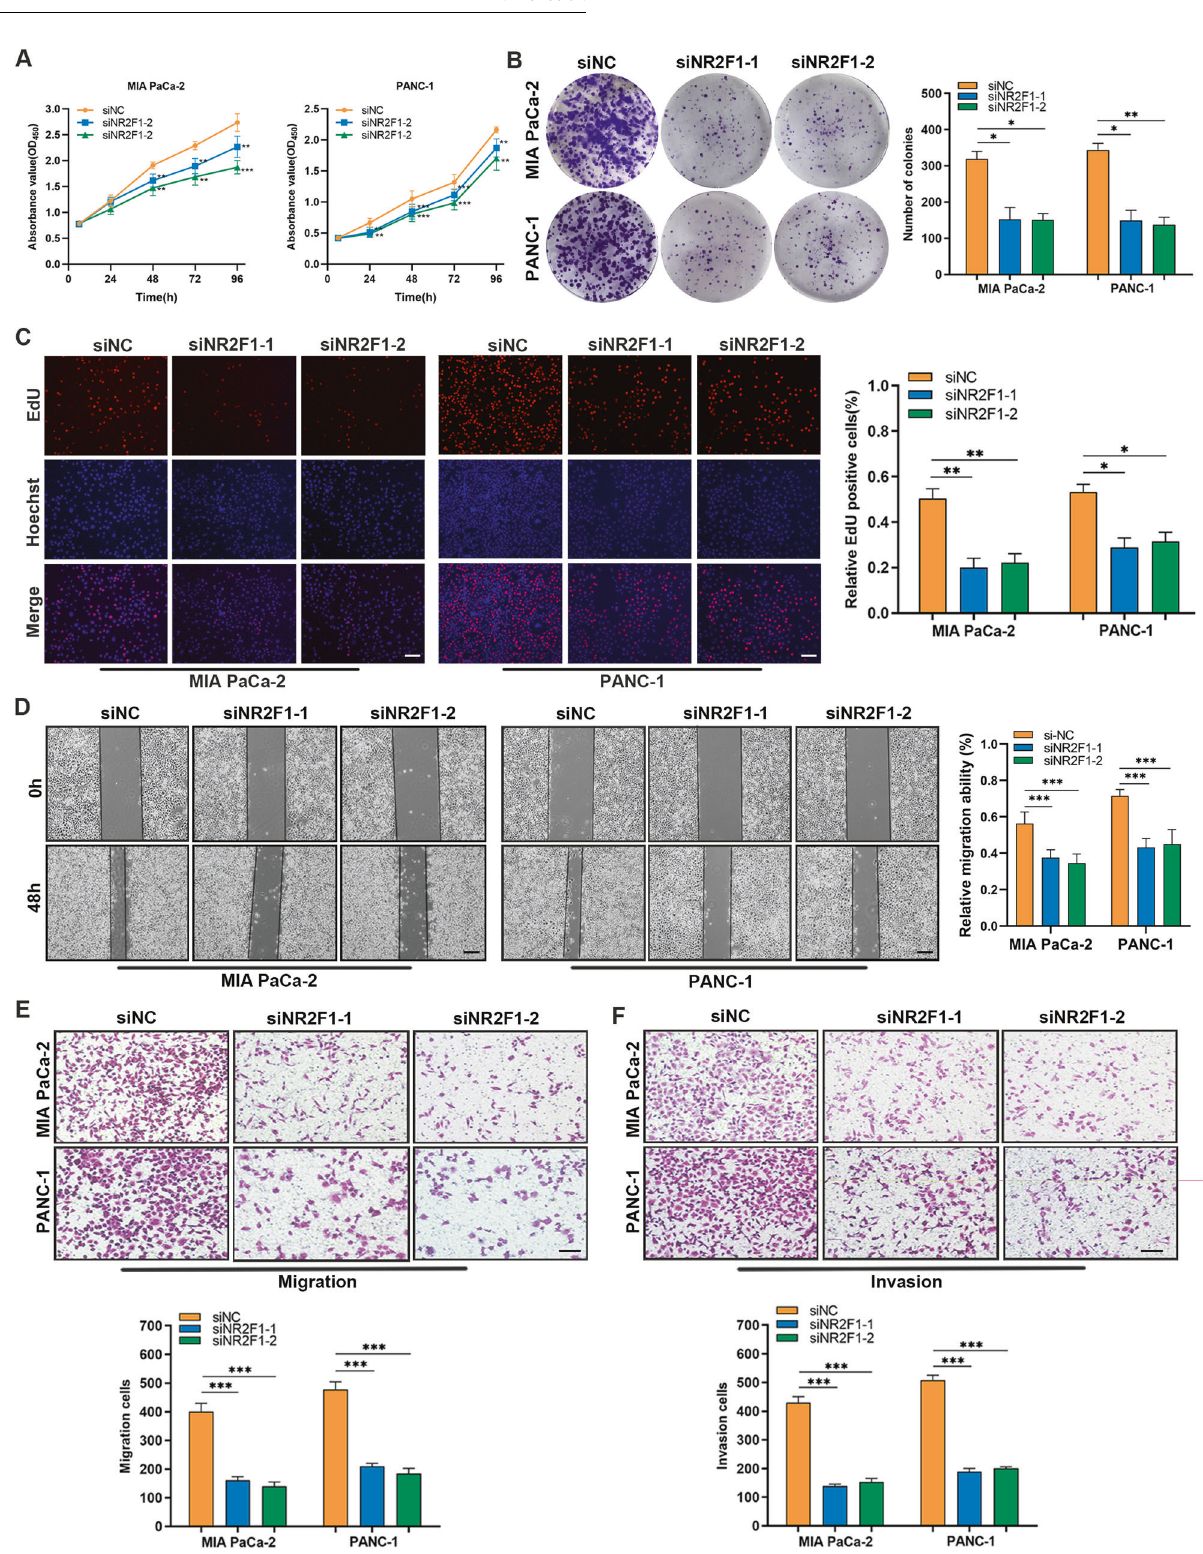
Fig. 5 Silencing NR2F1 decreases the proliferation, migration, and invasion capacities of PC cells. A CCK-8 assays in the siNR2F1 – 1, siNR2F1 – 2, and siNC groups of PANC-1 and MIA PaCa-2 cells. B Colony-formation assays in the NR2F1-silenced and NC groups of PANC-1 and MIA PaCa-2 cells. C EdU assays in the NR2F1-silenced and NC groups of PANC-1 and MIA PaCa-2 cells. D Wound-healing assay in the NR2F1- silenced and NC groups of PANC-1 and MIA PaCa-2 cells. E , F Transwell assays showing the migration ( E ) and invasion ( F ) abilities of the NR2F1- silenced and NC groups of PANC-1 and MIA PaCa-2 cells. Scale bar = 200 μ m. Data are expressed as mean ± SD. All experiments were repeated three times independently. * P < 0.05, ** P < 0.01, *** P < 0.001.